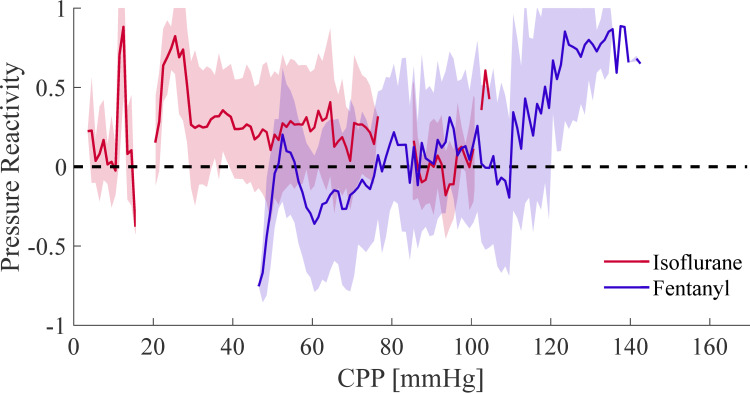
Pressure reactivity (PRx) values plotted as averages according to underlying CPP values.The red line indicates the averaged response of isoflurane anesthetized NHPs, while blue is the average of fentanyl. Shaded areas show the standard deviation. The dashed line marks a correlation of 0.